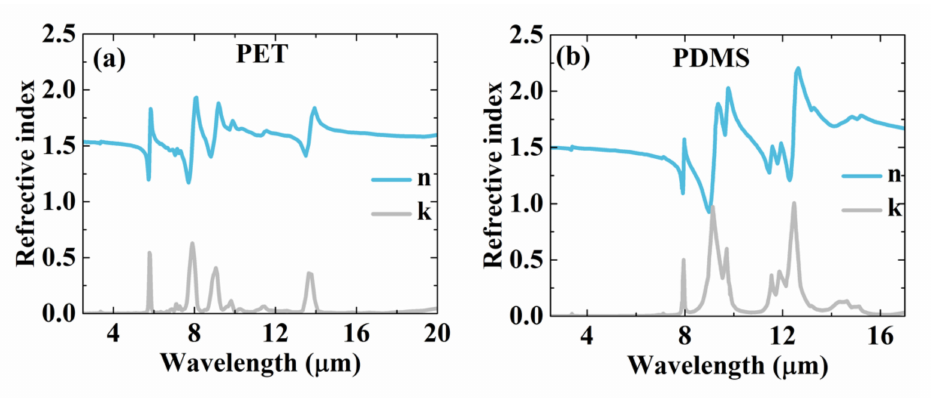
Figure A4. Optical constant of di ff erent materials. ( a ) PET and ( b ) PDMS in IR range [34,35].